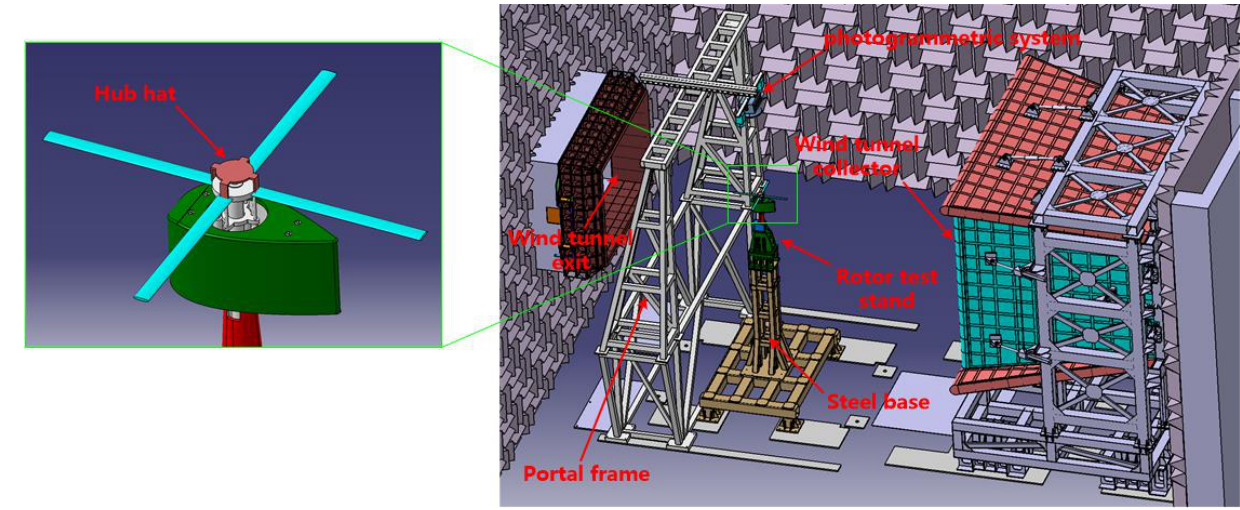
Figure 1. Overview of the experimental setup in the 5.5 m × 4 m Aeroacoustic Wind Tunnel at CARDC.